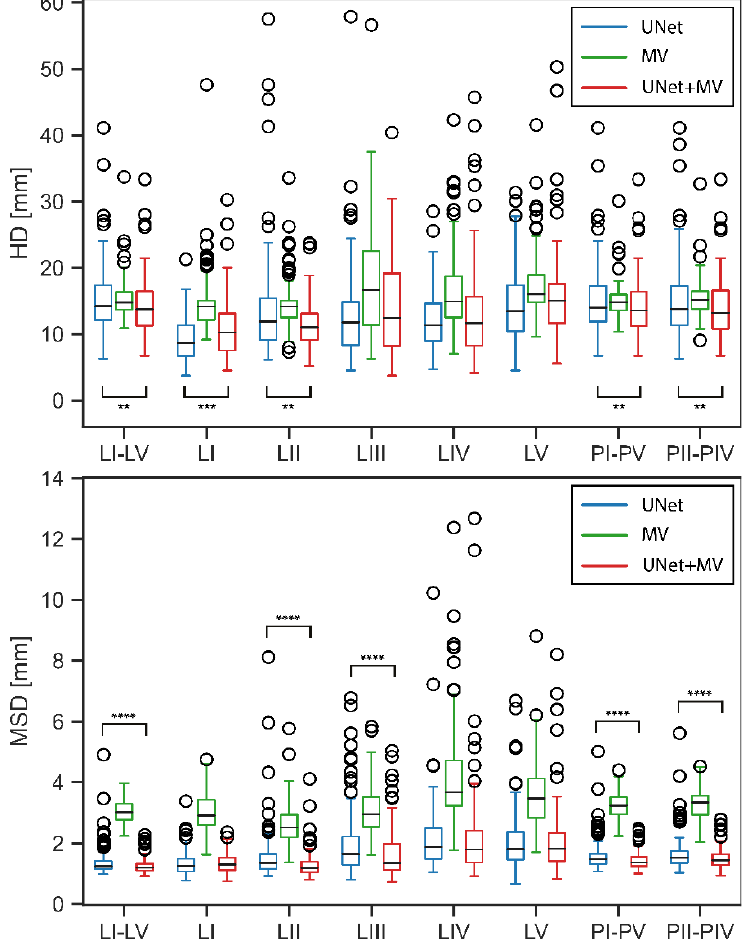
Figure 5. Spatial performances of UNet, MV and UNet+MV model configurations for DSC, HD and MSD measures. Statistical significance marking of the MV configuration was omitted because differences between MV and other model configurations were always significant. Structures for which differences between UNet and UNet+MV were statistically significant are denoted by significance bars. *: p < 0.05; **: p < 0.01; ***: p < 0.001; ****: p < 0.0001; Abbreviations: DSC: dice similarity coefficient; MV: multi-view; HD: Hausdorff distance; MSD: mean surface